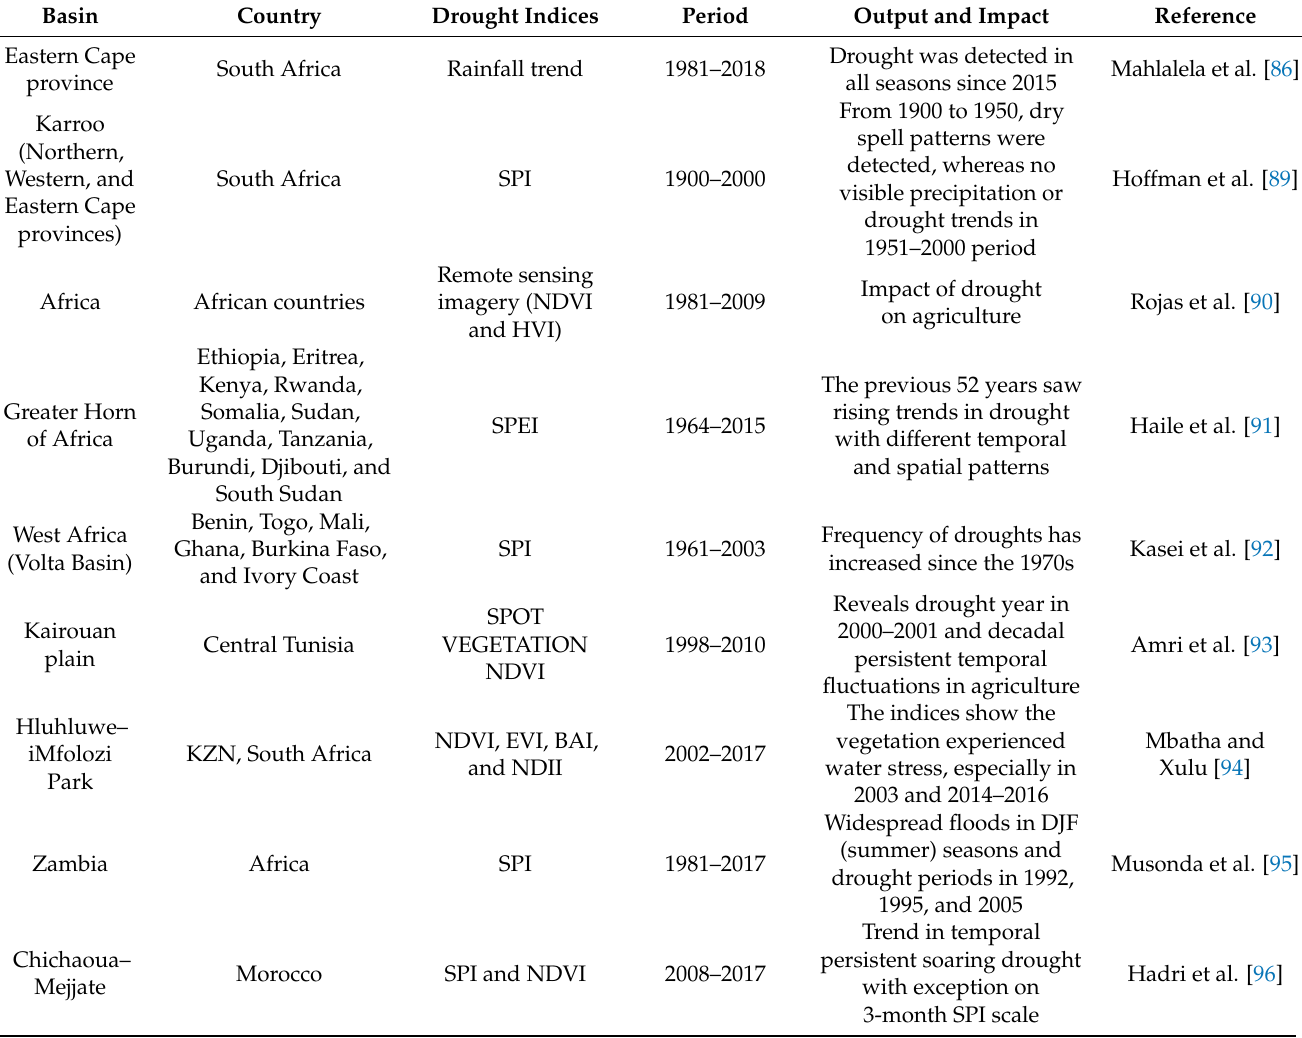
Table 8. Previous studies on drought trends across Africa and in South